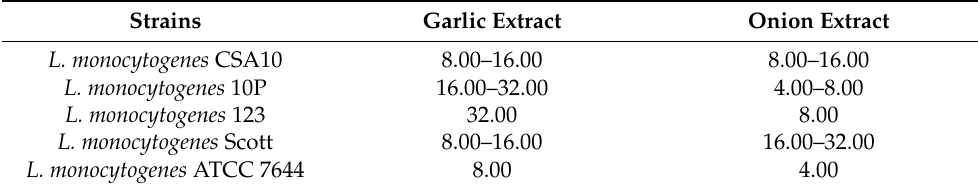
Table 3. Minimum and maximum value of minimum inhibitory concentration (MIC) of plant extracts. Data are expressed as µ